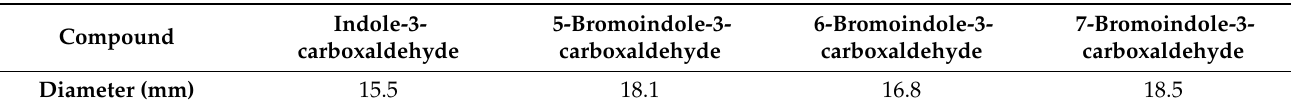
Table 1. Average diameter of zone of quorum sensing inhibition. 7-bromoindole-3-carboxaldehyde exhibited the greatest diameter. (A) Indole-3-carboxaldehyde, (B) 5-bromoindole-3-carboxaldehyde, (C) 6-bromoindole-3-carboxaldehyde,